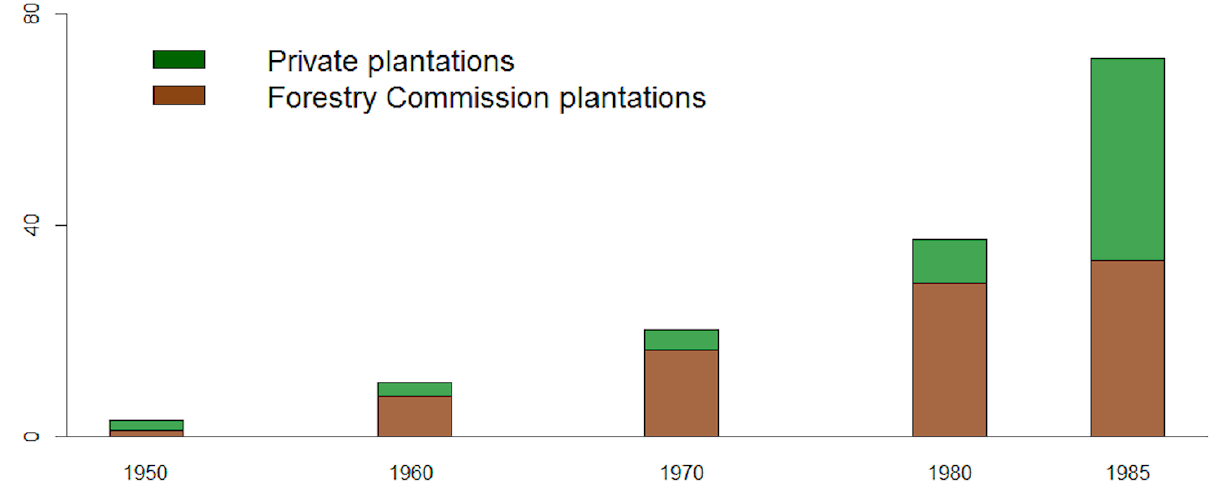
Figure 2. Extent and ownership of forest plantations in Caithness and Sutherland between 1950 and 1985. Adapted from Stroud et al .